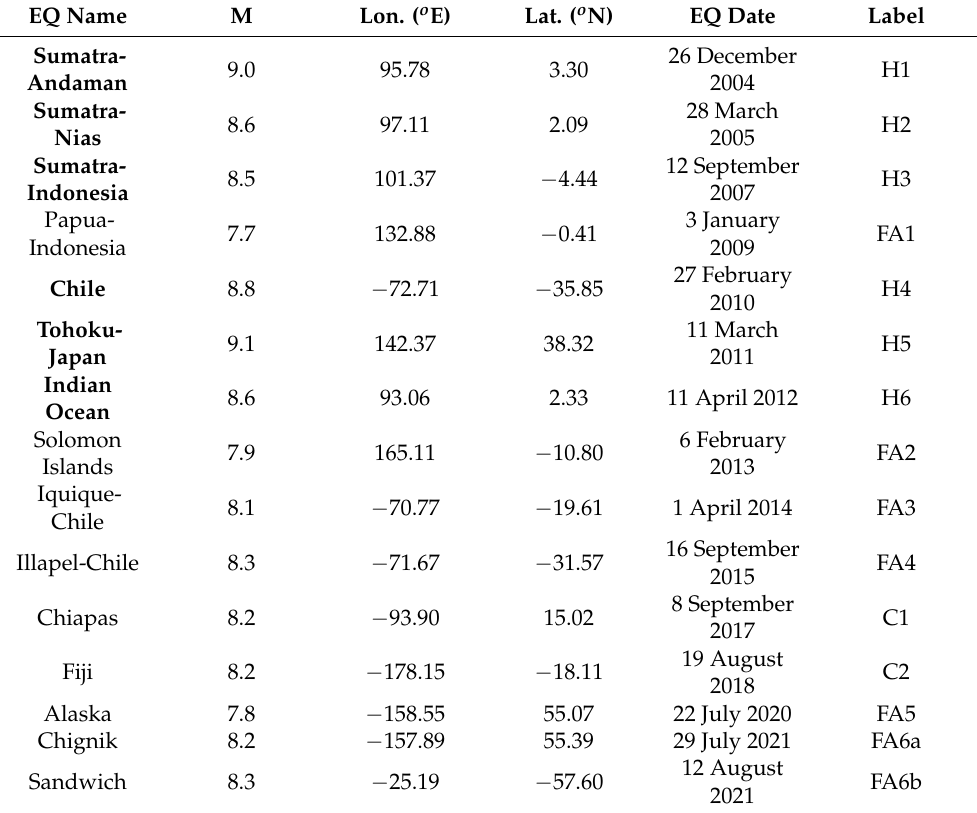
Table 2. List of the 15 strong EQs discussed in the text. In each case, in addition to the EQ magnitude, epicenter location, and date, a label is also ascribed by relating the EQ to β W minima. These labels have the following meaning: H1 to H6 correspond to true positive precursory variability minima, FA1 to FA6 to false positive variability minima (FA6a and FA6b are related to the same minimum FA6 of Table 1), while cases C1 and C2 correspond to the minima of β 160 observed on 24 April 2017 and 6 July 2018, respectively. For the details of the precursory variability minima see Table 1. The EQ names for EQs with M ≥ 8.5 are typed boldface. EQ Name M Lon. ( o E) Lat. ( o N) EQ Date